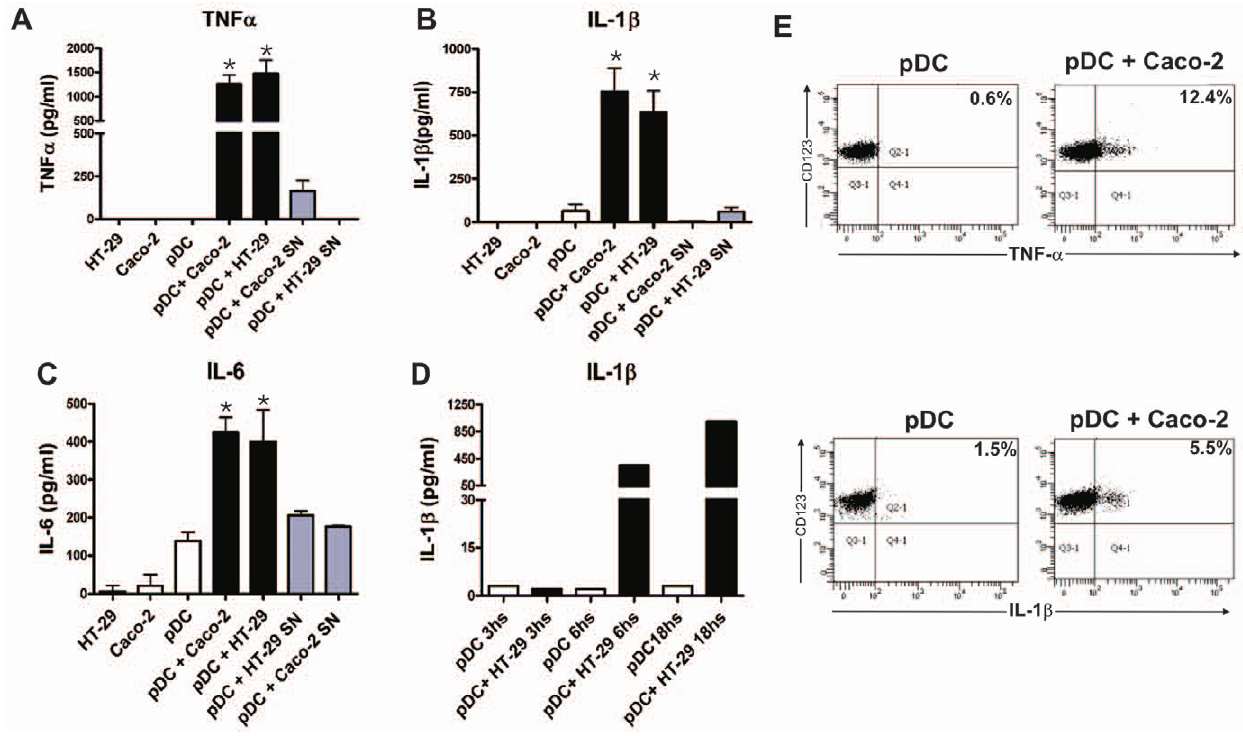
Figure 3. Epithelial cells stimulate the production of inflammatory cytokines by pDCs. ( A–C ) The epithelial cell lines HT-29 and Caco-2 were grown to confluence in 96 well flat bottom plates. pDCs (1 6 10 5 /200 m l) were cultured alone (controls), with HT-29 or Caco-2 cells, or with supernatants (SN) collected from confluent HT-29 or Caco-2 cells cultured for 12 h. Then, the production of TNF- a , IL-1 b , and IL-6 was evaluated in cell supernatants by ELISA. Results are the mean 6 SEM of eight experiments performed in duplicate. (*p , 0.05 vs controls). The levels of TNF- a and IL-1 b produce by HT-29 and Caco-2 cells cultured alone were undetectable (below the detection limit of the ELISA assays). (D) Kinetic of the production of IL-1 b by pDCs cultured with the epithelial cell line HT-29. A representative experiment (n=2) is shown. (E) Caco-2 cells were grown to confluence in 96 well flat bottom plates. pDCs (1 6 10 5 /200 m l) were cultured alone or with Caco-2 cells for 12 h. In the assays directed to evaluate the production of TNF- a , Brefeldin A (10 m g/ml) was added during the last 6 h of culture. Then, the production of TNF- a and IL-1 b was evaluated by intracellular staining and flow cytometry. A representative experiment (n=3) is shown.